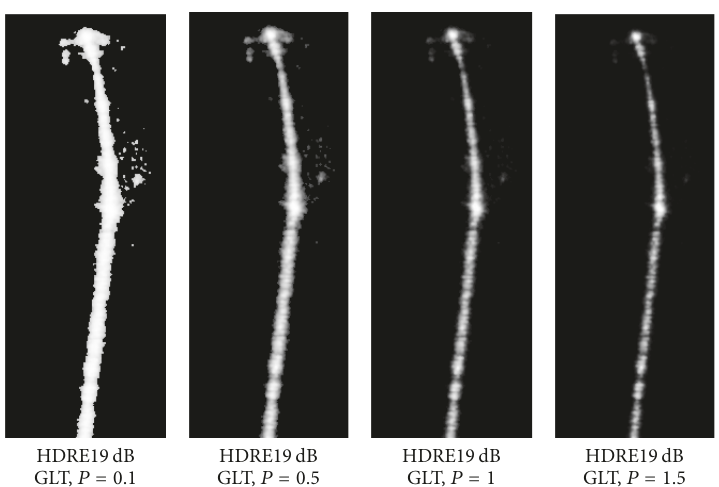
Figure 11: Image of laser line processed with GLT.